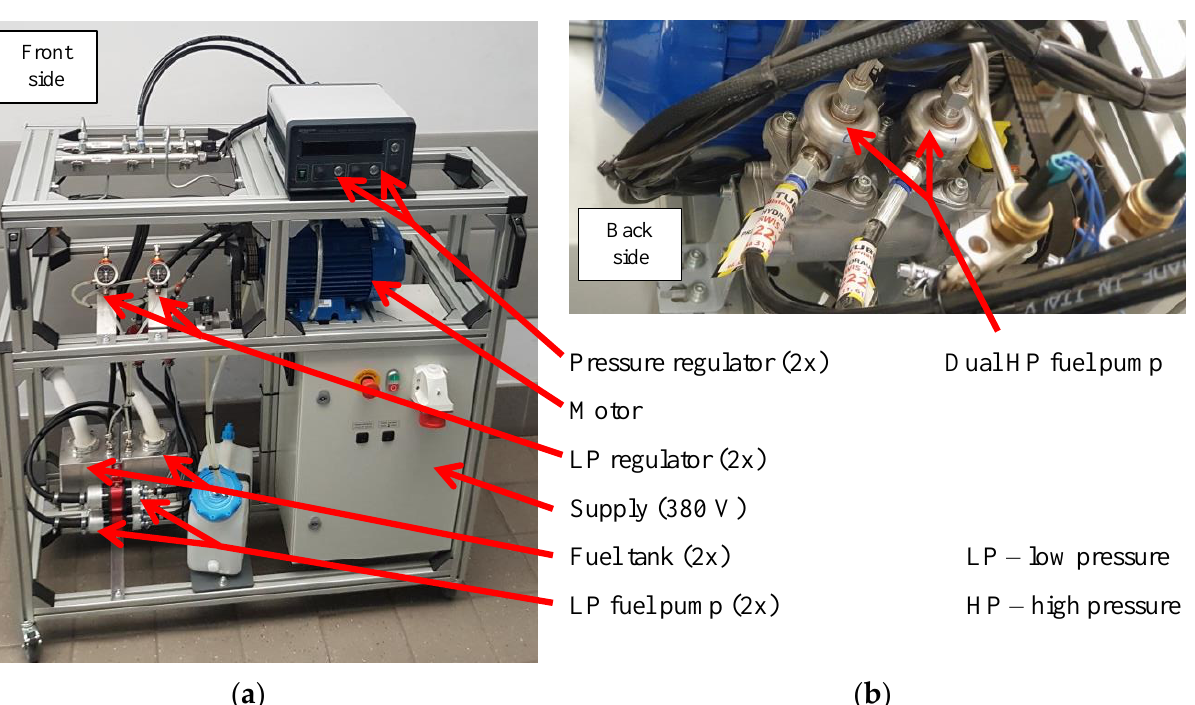
Table 3. Technical data for the Siemens VDO piezoelectric injector [35].